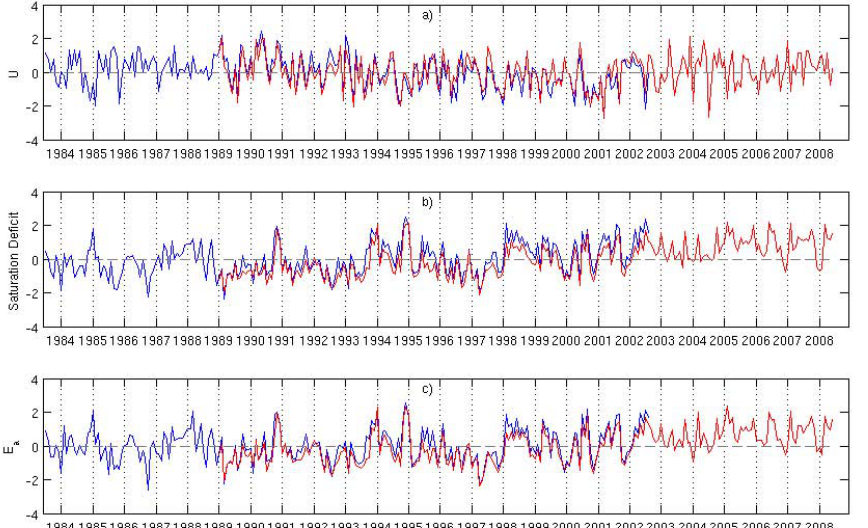
Fig. 4. Normalised anomalies of (a) 10m wind speed U by ERA-40 (blue line) and ERA Interim (red line) (b) VPD by ERA-40 (blue line) and ERA Interim (red line) and (c) bulk aerodynamic evaporation E a , computed by data from ERA-40 (blue line) and ERA Interim (red line).